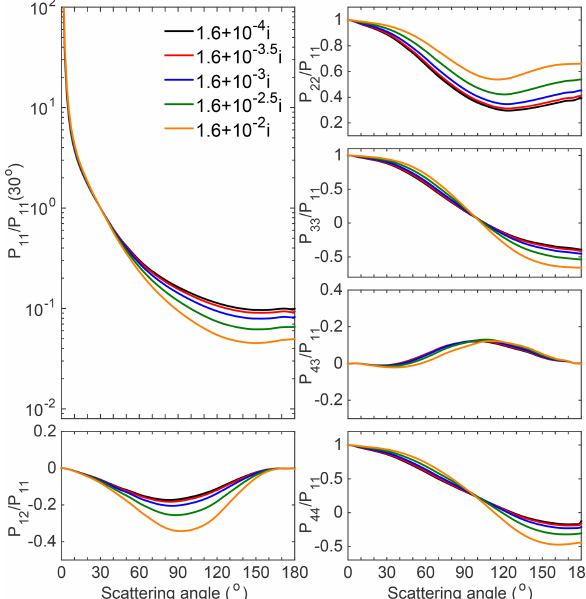
Figure 4. Similar to Fig. 3, except that the real part is fixed at 1.6, the imaginary part is changed from 10 − 4 to 10 − 2 with a step of 10 0 . 5 , and the particles are assumed to have the size distribution of Lokon volcanic